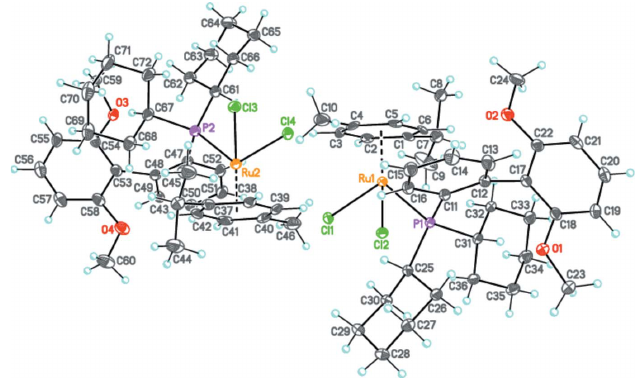
Figure 1 A view of the molecular structure of compound I , with atom labelling. Displacement ellipsoids are shown at the 50% probability level.